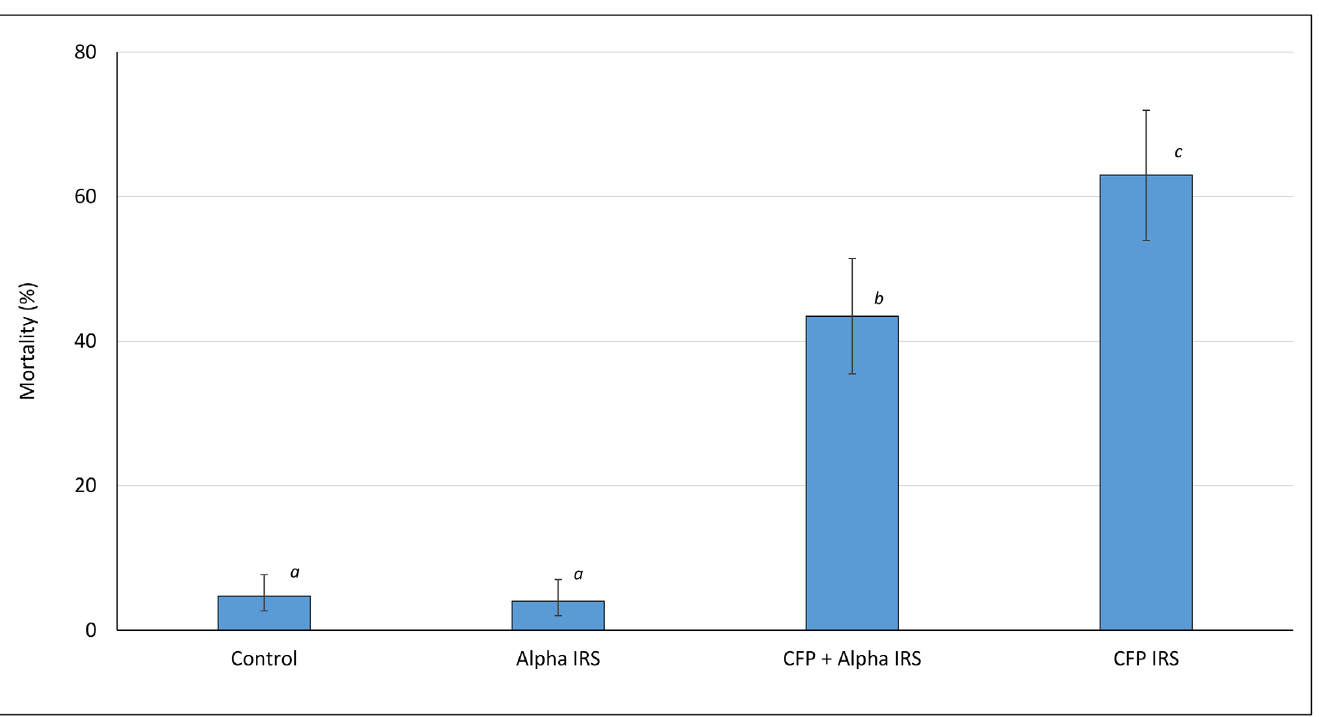
Fig 1. Overall mortality rates of wild pyrethroid resistant Anopheles gambiae in IRS-treated experimental huts in Cove, Benin. Bars bearing the same letter label do not differ significantly (P > 0.05). Error bars represent 95% CI. alpha = alpha-cypermethrin, CFP = chlorfenapyr.